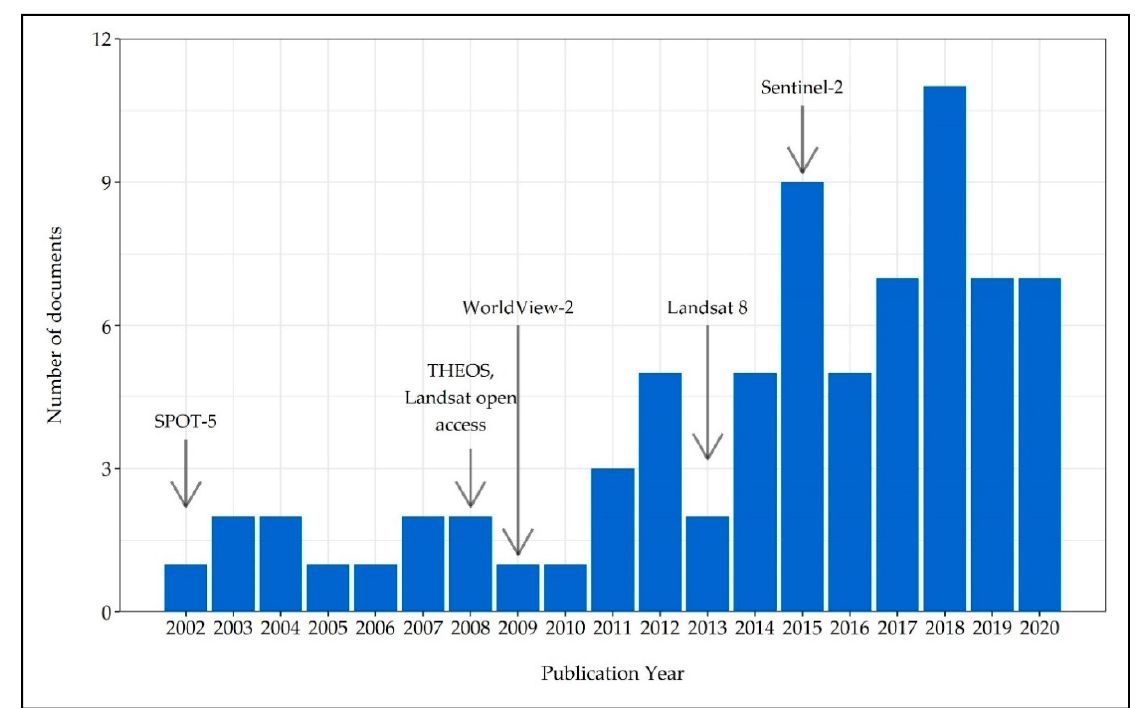
Figure 2. Distribution of the reviewed documents based on publication year (The arrows show important satellite launch years and the year Landsat implemented open access data).